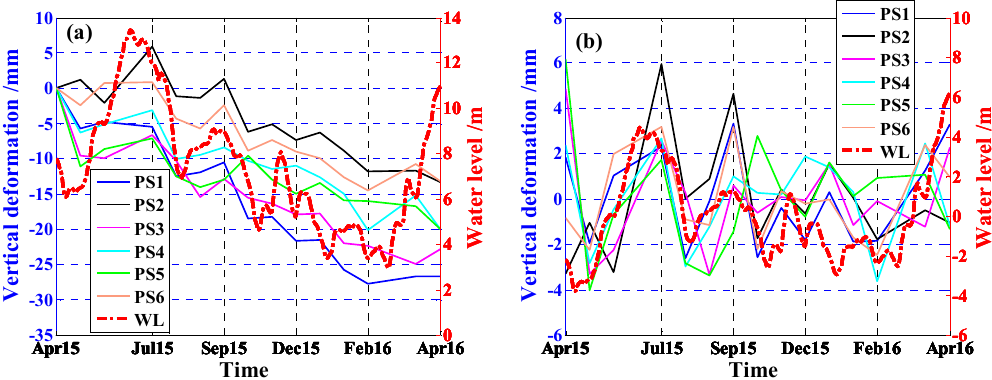
Figure 14. ( a ) Surface vertical deformation time series with respect to PS points labeled as PS1–PS6 in Figure 13 versus water level (WL) changes (red-dotted line) in Yangtze River. ( b ) Detrended surface vertical deformation time series relevant to the above PS points versus detrended water level changes (red dotted line) in Yangtze River. Table 3. The GRG between the subsidence and water level of Yangtze River before and after the linear trend is removed and the standard deviations of displacement with respect to the six PS points. GRG Standard Deviation PS Points Time Series Detrended Time Series Displacement (mm) PS1 0.82